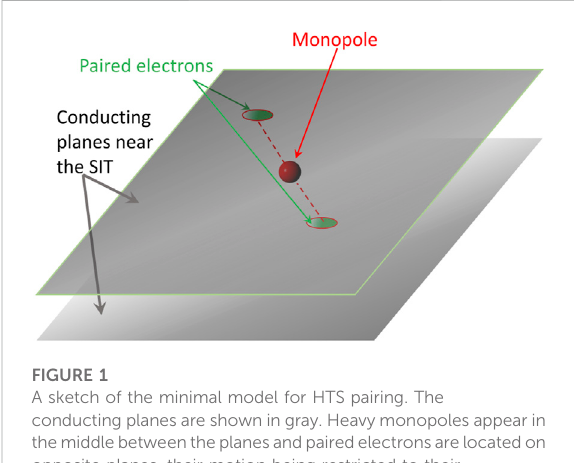
FIGURE 1 A sketch of the minimal model for HTS pairing. The conducting planes are shown in gray. Heavy monopoles appear in themiddlebetweentheplanesandpairedelectronsarelocatedon opposite planes, their motion being restricted to their respective